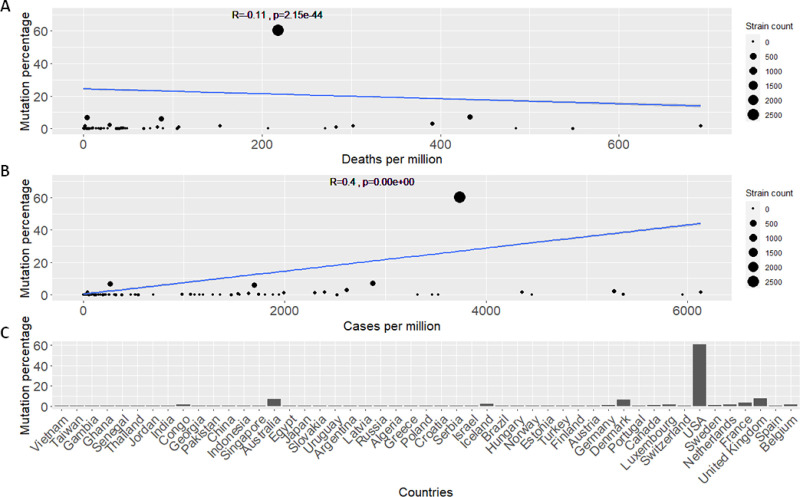
Analyses plots for ORF3a protein mutation at position 25563 (Q57H).A. Regression model line showing the simplified fit for mutations percentage across countries and the death rate per million for each country. Pearson’s correlation is shown by the R value accompanied by the p-value of the correlation coefficient. B. Similar regression fit for mutations percentage across countries this time showing cases per million for each country. C. Detailed histogram of the percentage occurrence of the mutation across different countries. Countries are sorted with increasing deaths per million.